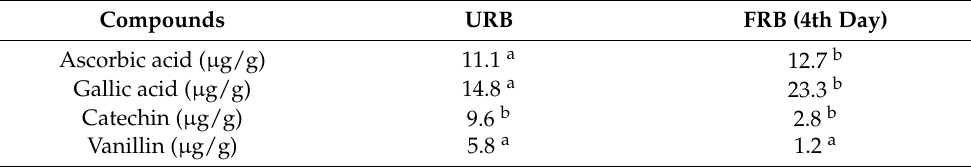
Table 3. Phenolic acid composition of un-fermented and fermented rice bran (4th day).